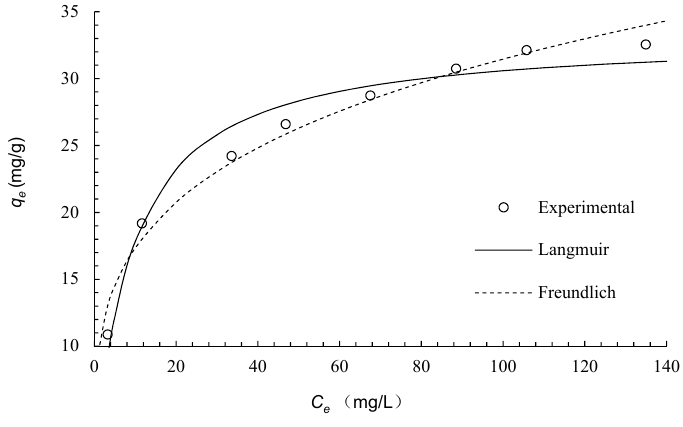
Figure 6. Adsorption isotherms of Cu(II) onto ICSP.